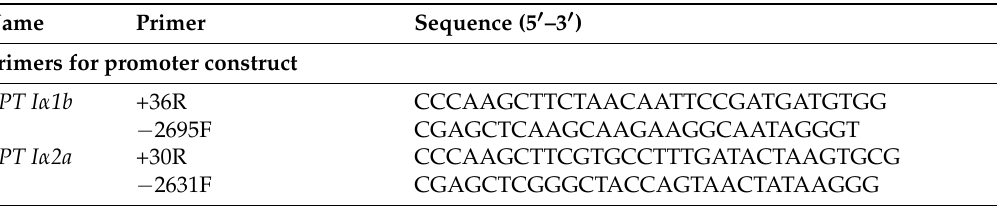
Table 1. Primers used in the